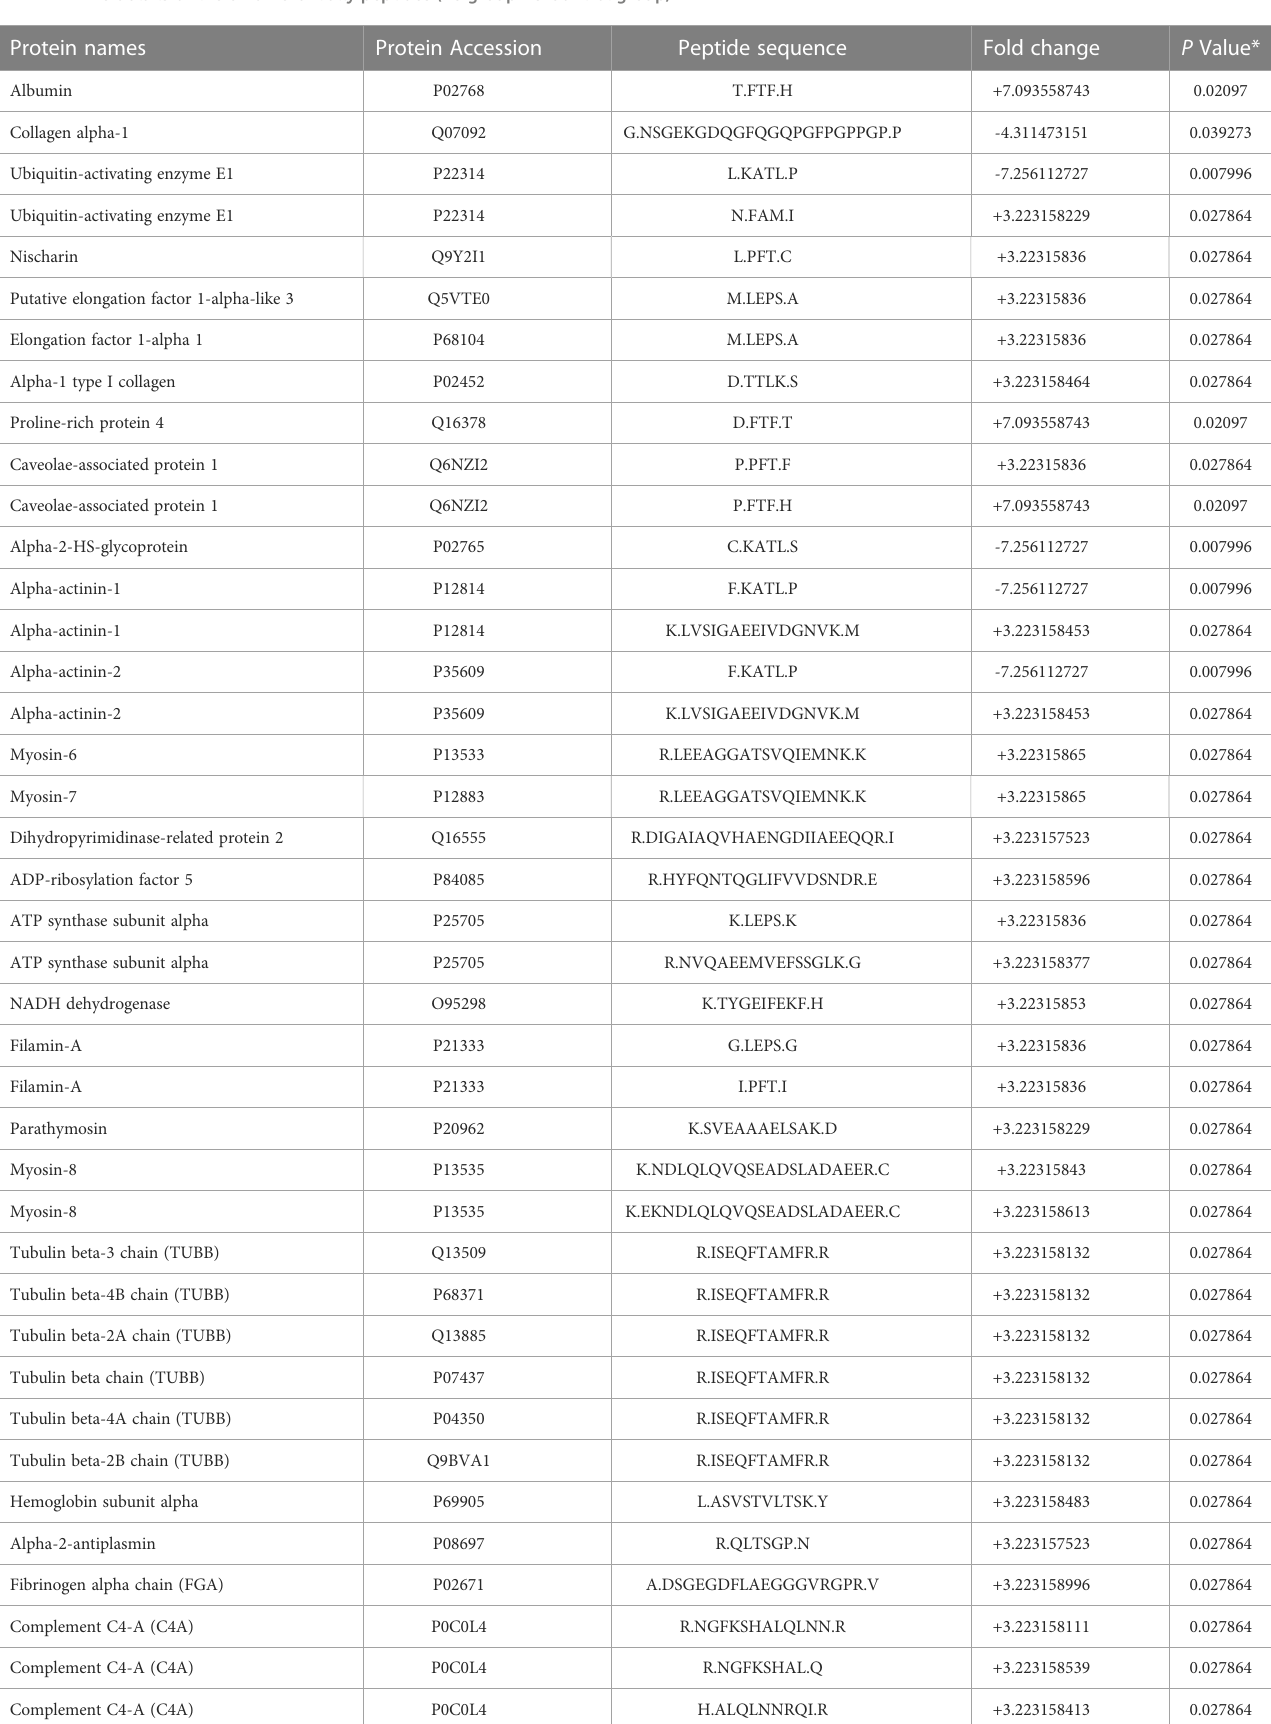
TABLE 2 The details of the 52 differentially peptides (AS group VS Control